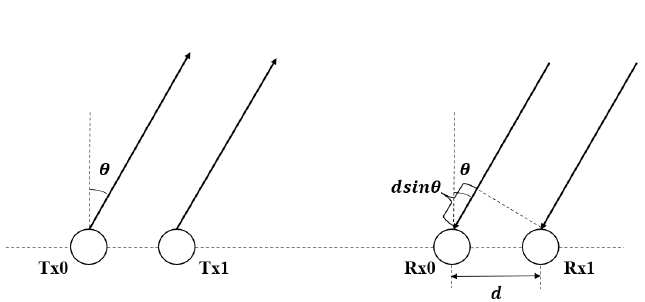
Figure 2. Linear distributed transmitters and receivers in MIMO